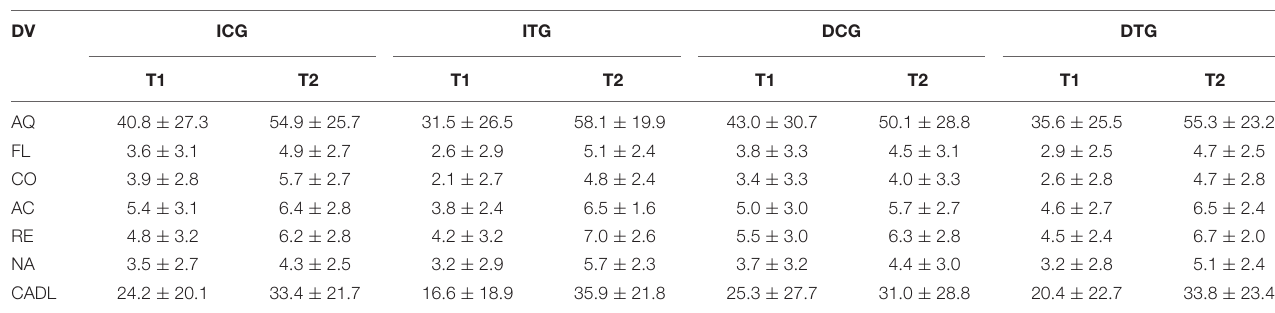
TABLE 4 | WAB and CADL performance in each subgroup ( M ± SD